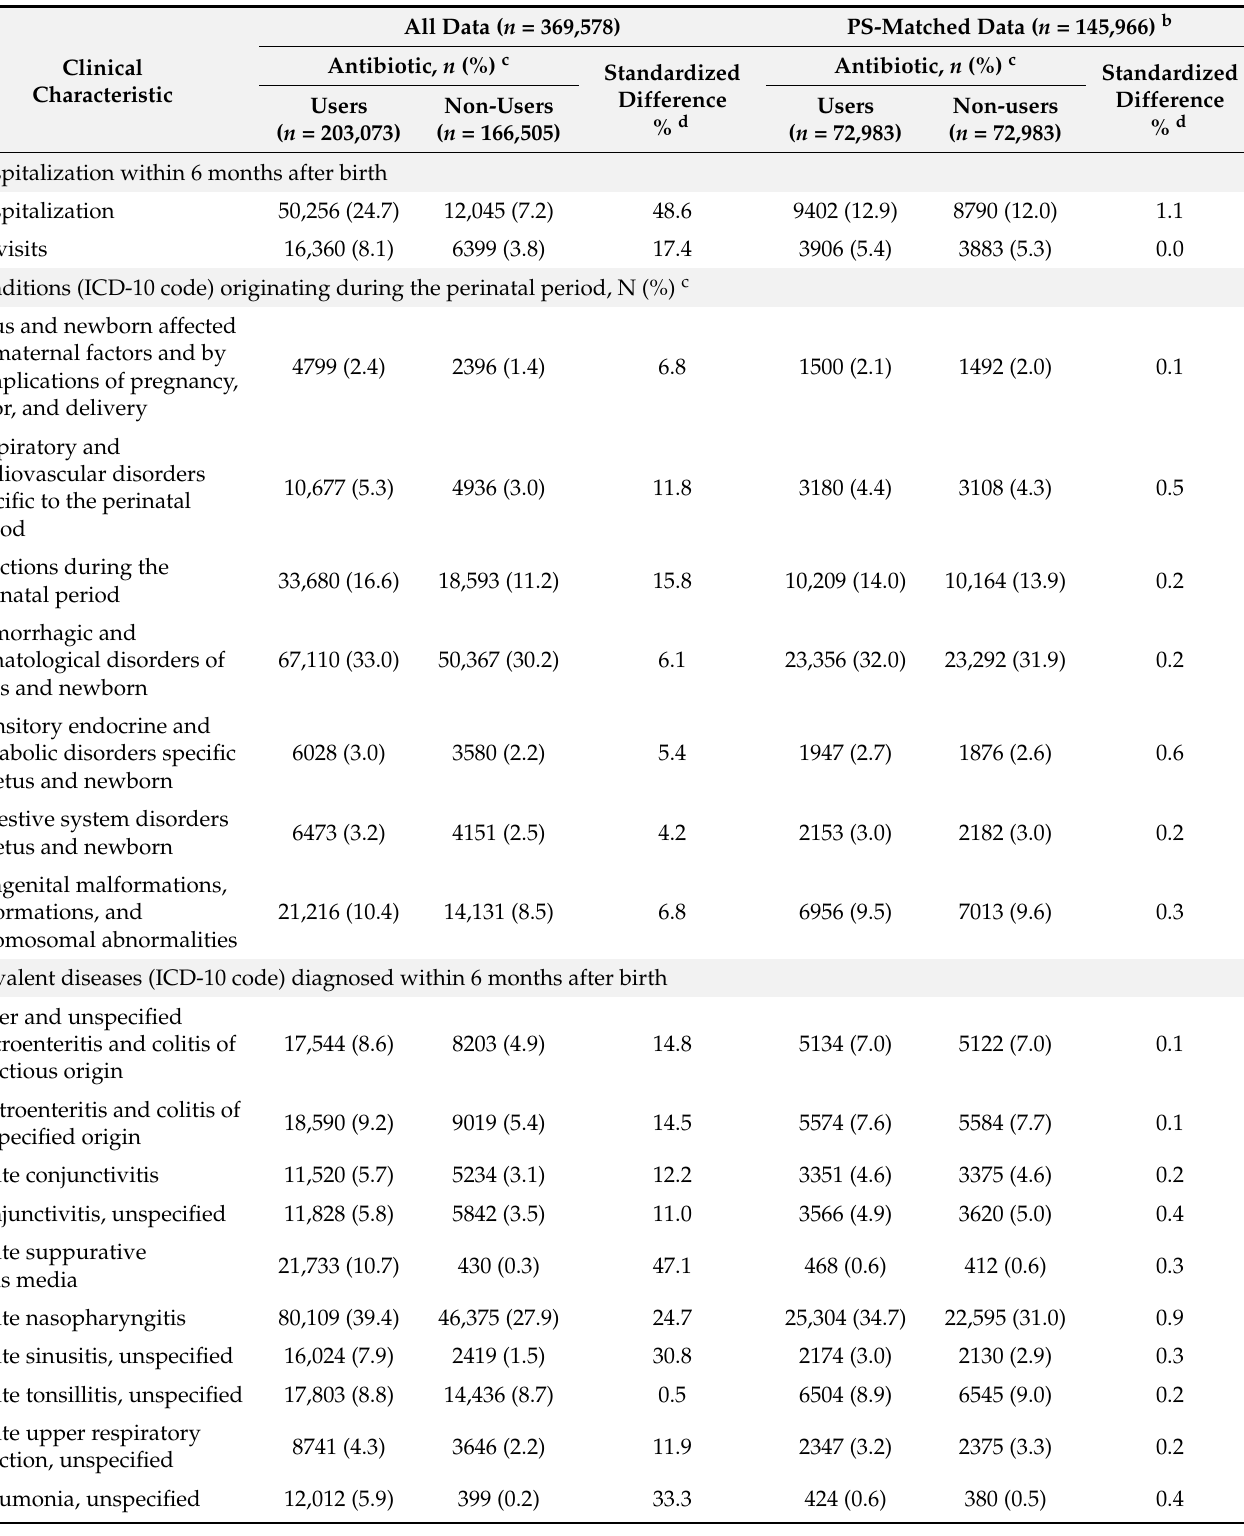
Table 2. Basic clinical characteristics of children in the main cohort a